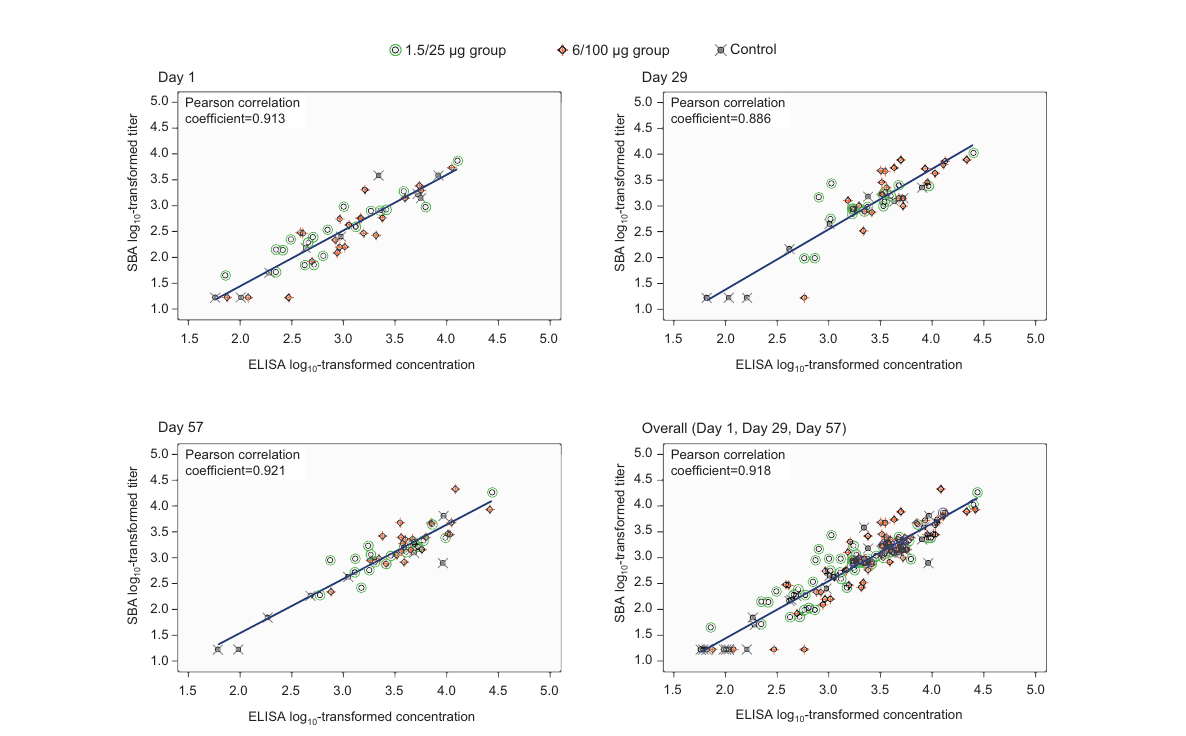
FIGURE 4 Correlation between anti- S. sonnei LPS serum IgG antibody concentrations and SBA titers (full analysis set). SBA, serum bactericidal activity; ELISA, enzyme-linked immunosorbent assay; IgG, immunoglobulin G; Day 1, pre-vaccination; Day 29, 28 days post- fi rst vaccination; Day 57, 28 days post-second vaccination; 1.5/25 µg group, participants receiving the 1.5/25 µg O antigen/protein vaccine formulation; 6/100 µg group, participants receiving the 6/100 µg O antigen/protein vaccine formulation; Control, participants receiving a quadrivalent meningococcal conjugate vaccine at Day 1 and a vaccine against tetanus, diphtheria, and acellular pertussis at Day